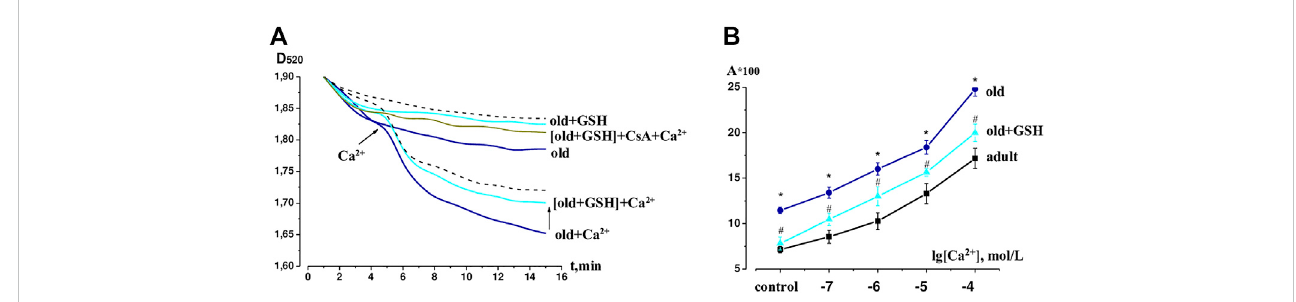
FIGURE 2 TheeffectsofGSHpretreatmentonthemPTPinheartofoldrats. (A) NativecurvesofCa 2+ -inducedmitochondrialswelling. (B) Changesinthesensitivity